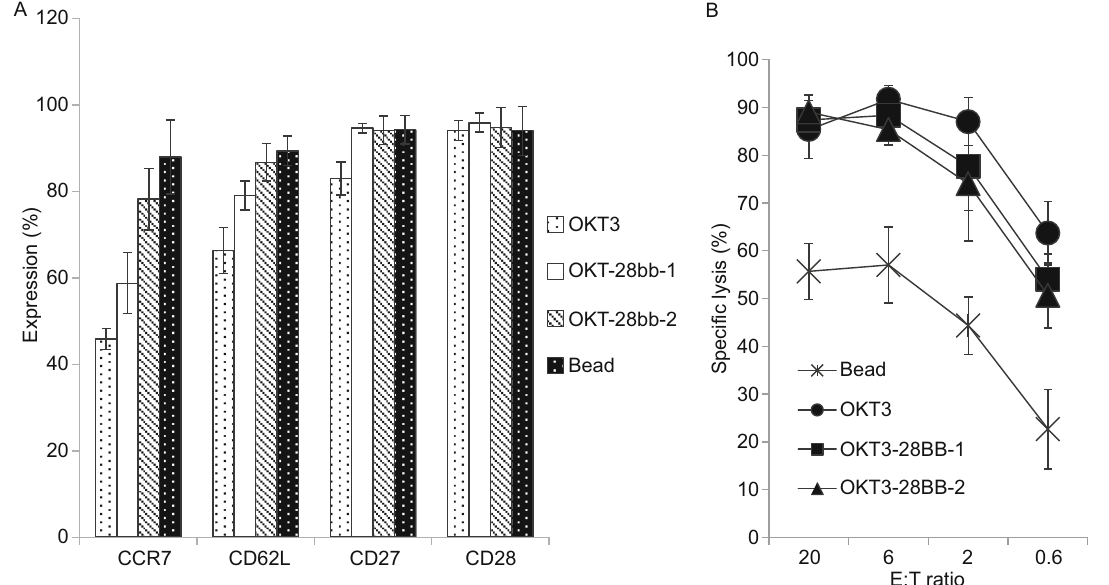
Figure 4. T cells with a less differentiated phenotype and potent lytic activity were expanded by RNA co-electroporation. (A) Detection of less differentiated Tcell markers using fl ow cytometry for Tcells generated by OKT3/IL-2 (OKT3), OKT3-28BBZ RNA electroporation (OKT-28bb-1) or OKT3-28BBZ, CD86 and 4-1BBL RNA co-electroporation (OKT-28bb-2). (B) Four-hour fl ow-based CTL assay of CD19.BBZ CAR RNA-electroporated T cells.